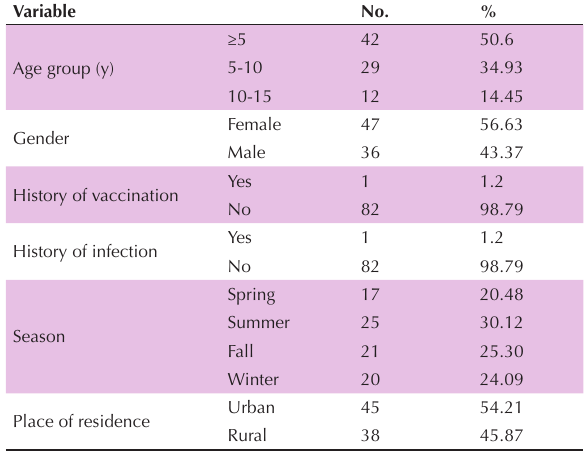
Table 1. Frequency distribution of demographic characteristics of the studied patients Variable